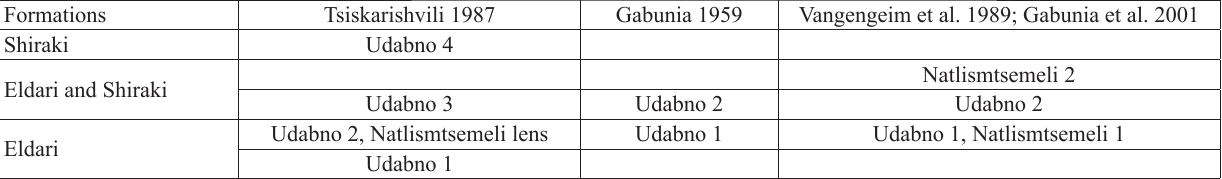
Table 4. Numbering of the fossil-bearing horizons of the Udabno site according to different authors. Formations